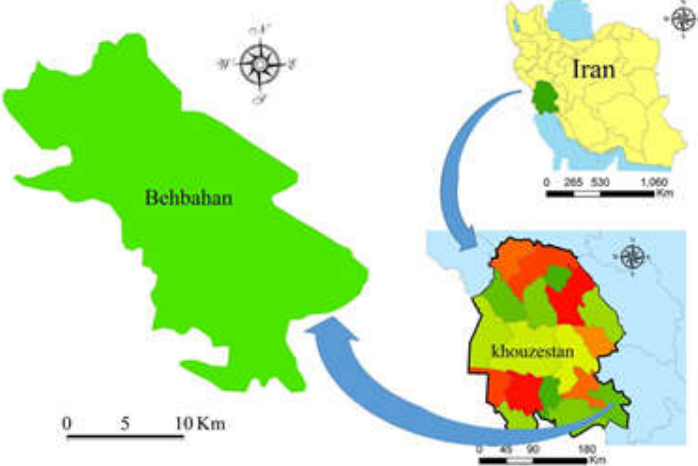
Fig. 1: Geographic location of the study